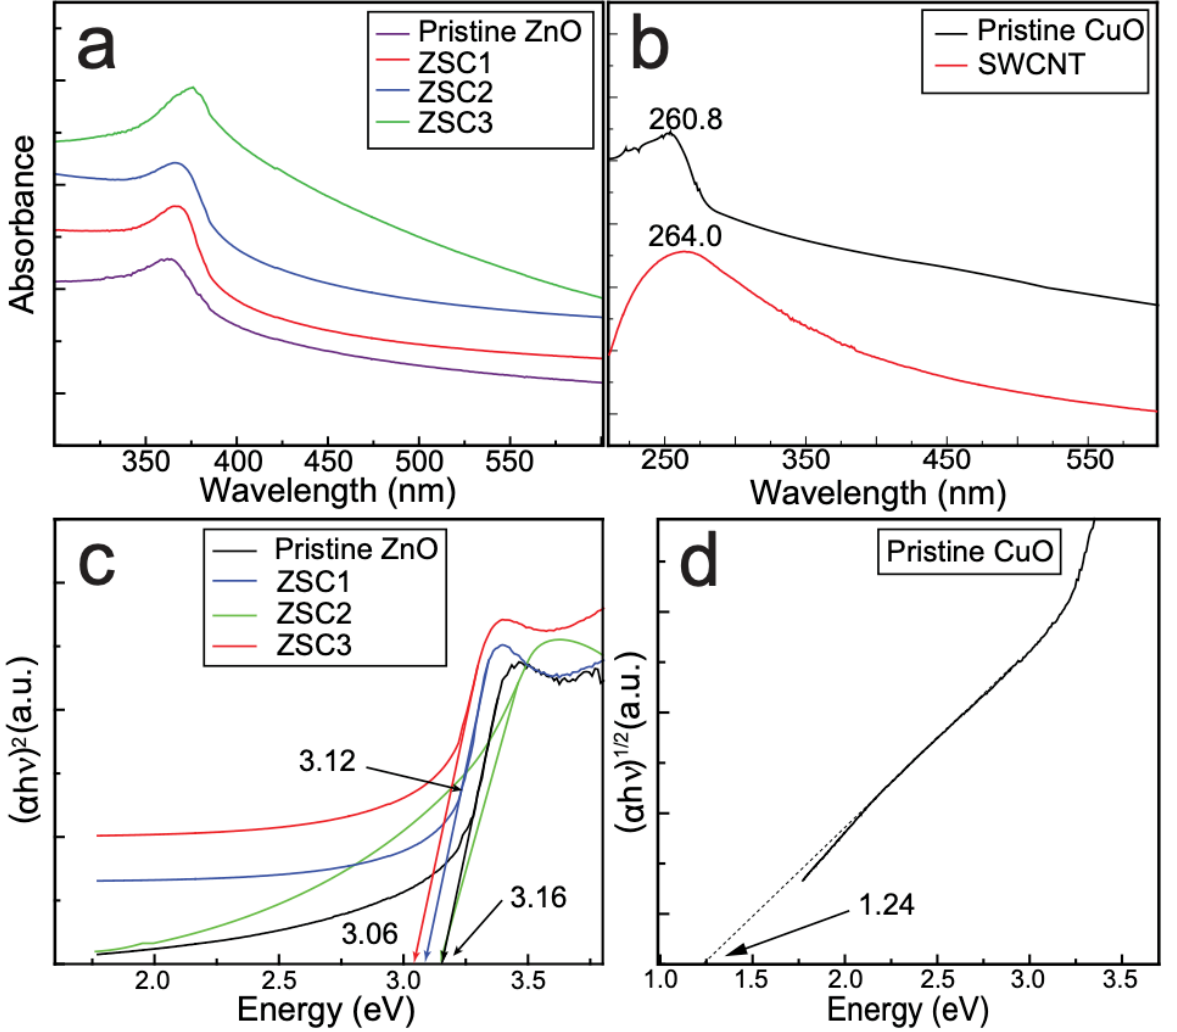
Figure 7. ( a ) The combined plot of the UV – Vis spectra of pristine ZnO, ZSC1, ZSC2, and ZSC3. ( b ) The absorption spectra of pristine CuO, and SWCNTs. ( c ) Tauc plots obtained by applying the direct-bandgap method, depicting the bandgap energies of the pristine ZnO and ZSC composites. ( d ) Tauc plot for pristine CuO obtained by applying the indirect bandgap method.